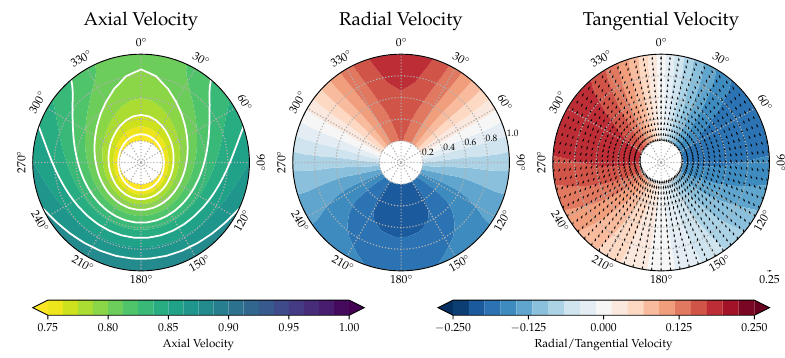
Figure 2. Potential wake field.